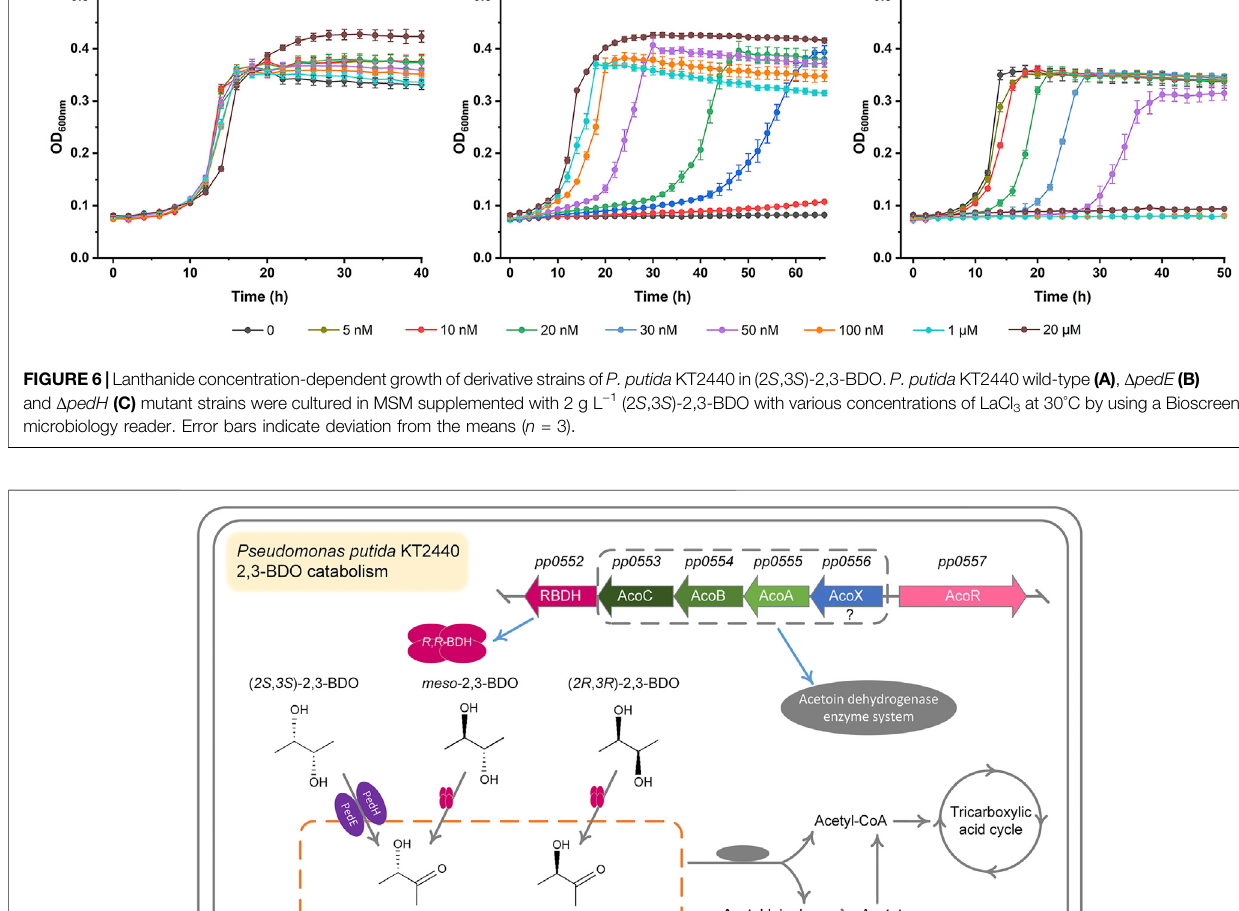
Frontiers in Bioengineering and Biotechnology |